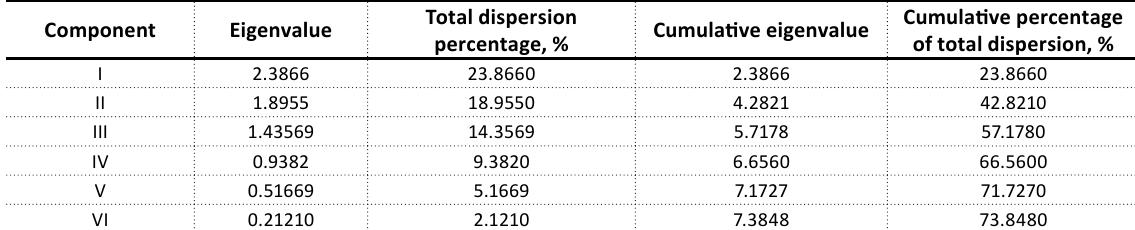
Table 2. Dispersion and eigenvalues of the main components of the investigated enterprises’ innovation activities